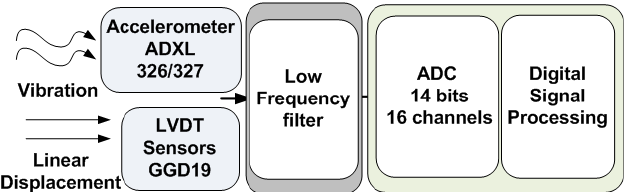
Fig. 3. Schematic diagram of sensor